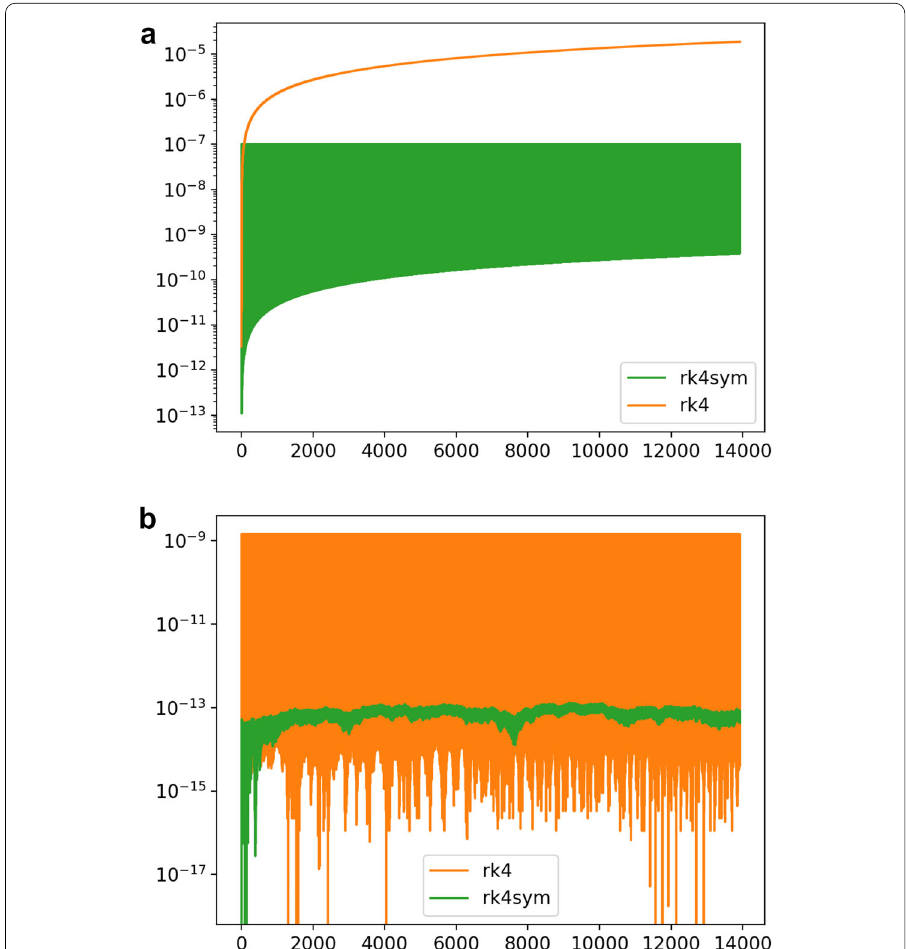
Fig. 7 Eight-orbit configuration. Error on the Hamiltonian ( a ) and on the angular momentum ( b )